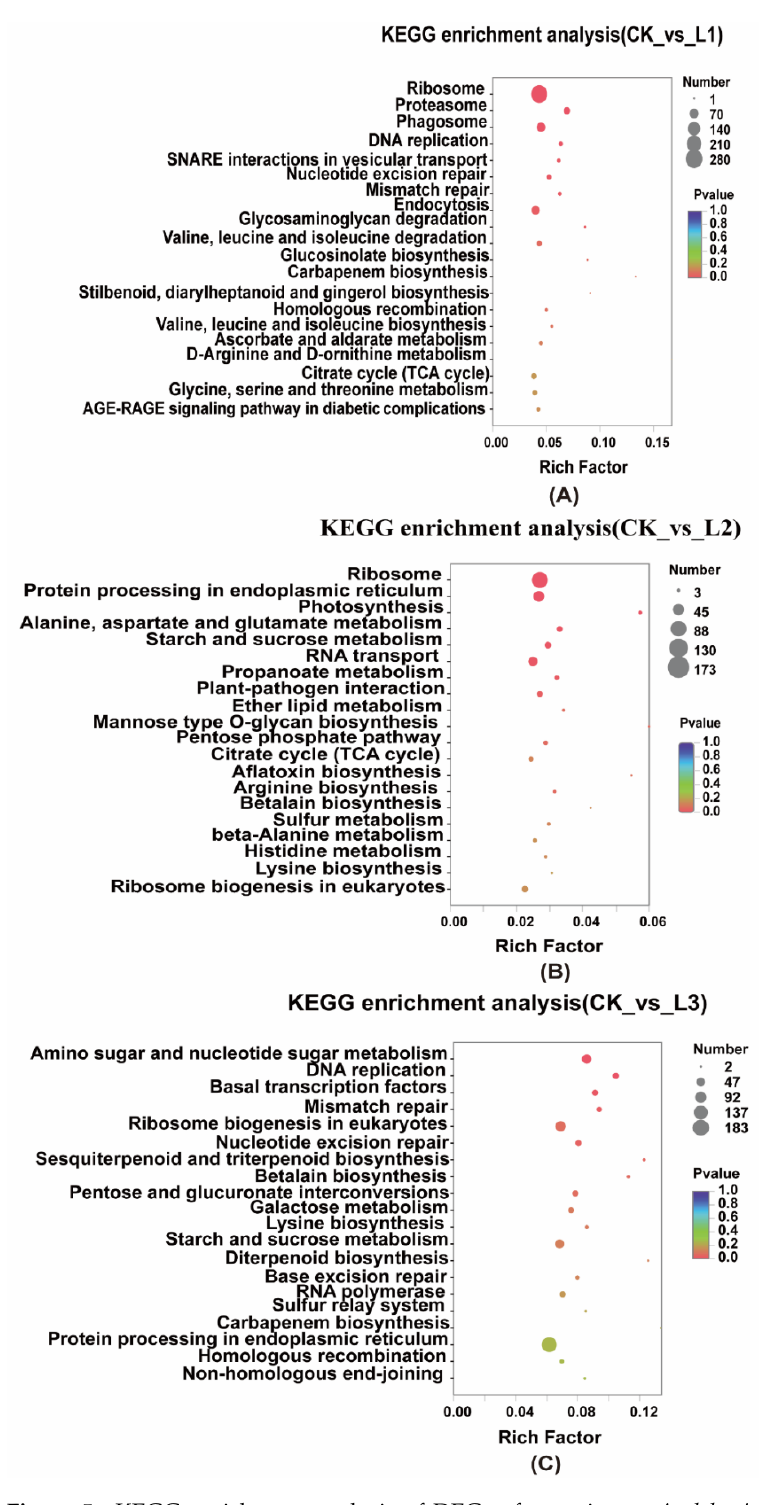
Figure 5. KEGG enrichment analysis of DEGs of root tissues A. dahurica under different light intensities. ( A ) CK vs. L1; ( B ) CK vs. L2; ( C ) CK vs. L3 .